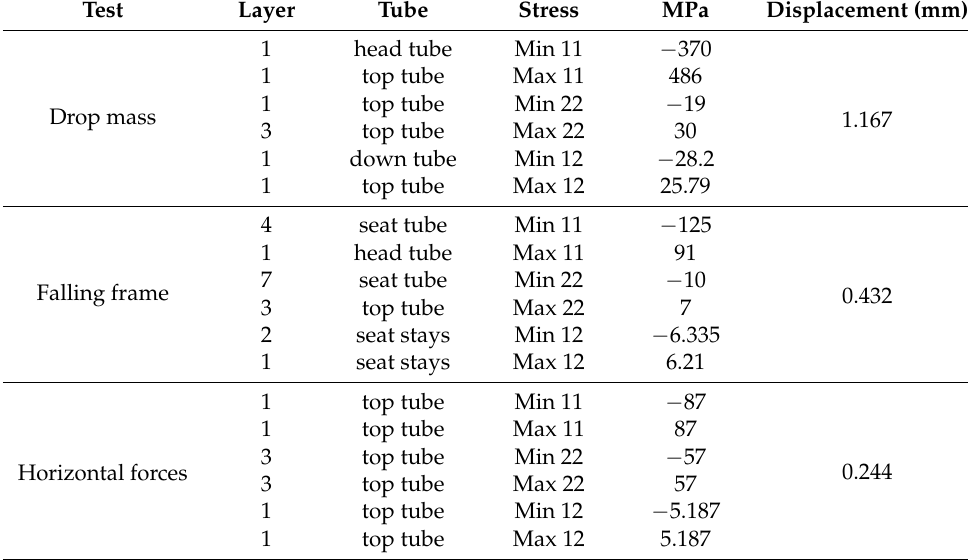
Table 23. Stress and displacement results of stacking scenario